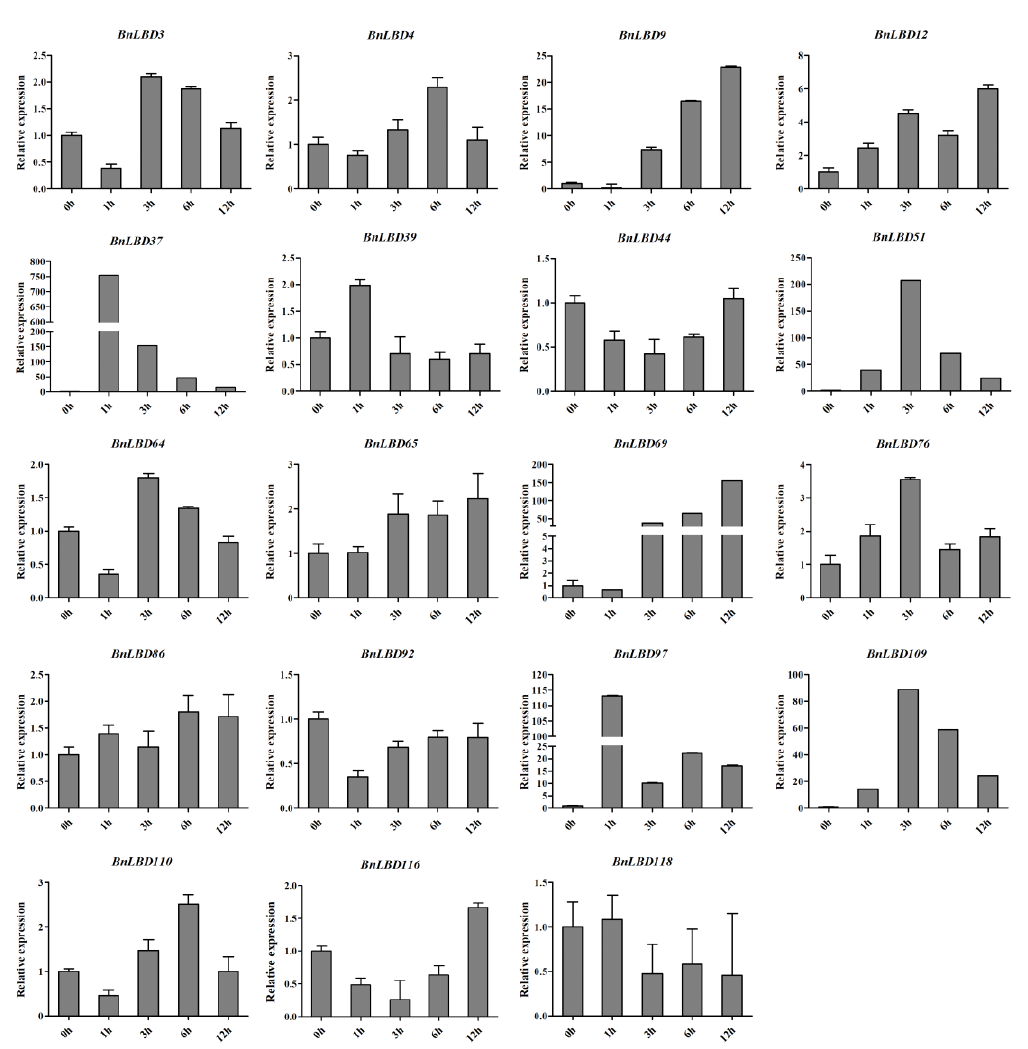
Figure 10. The expression pattern of BnLBD genes under abscisic acid (ABA) treatment. Data were normalized to BnActin 2 gene and vertical bars indicate standard deviation.